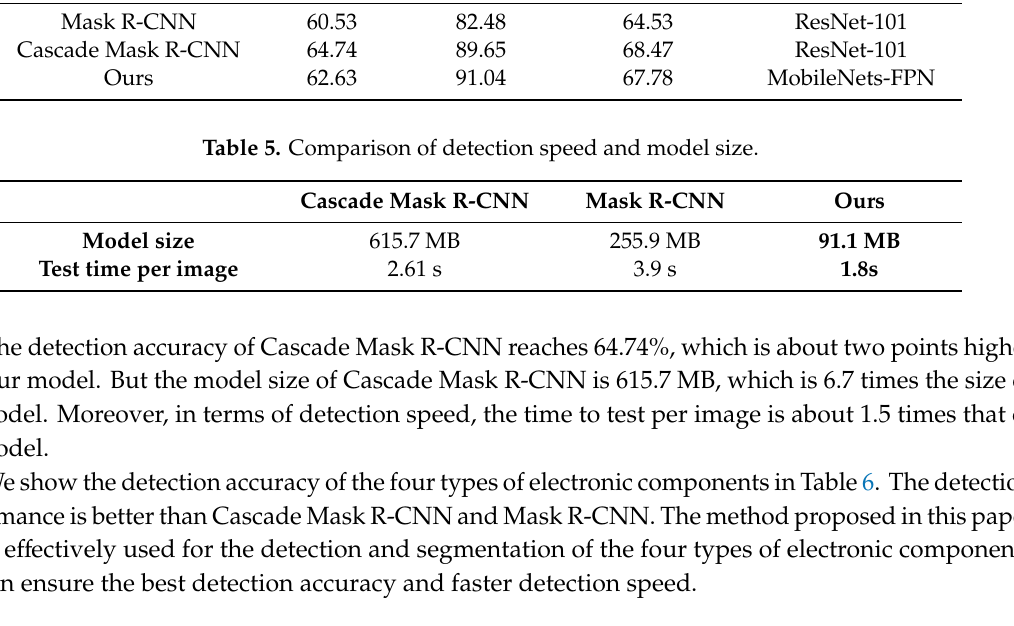
Table 6. Comparison of AP values in object